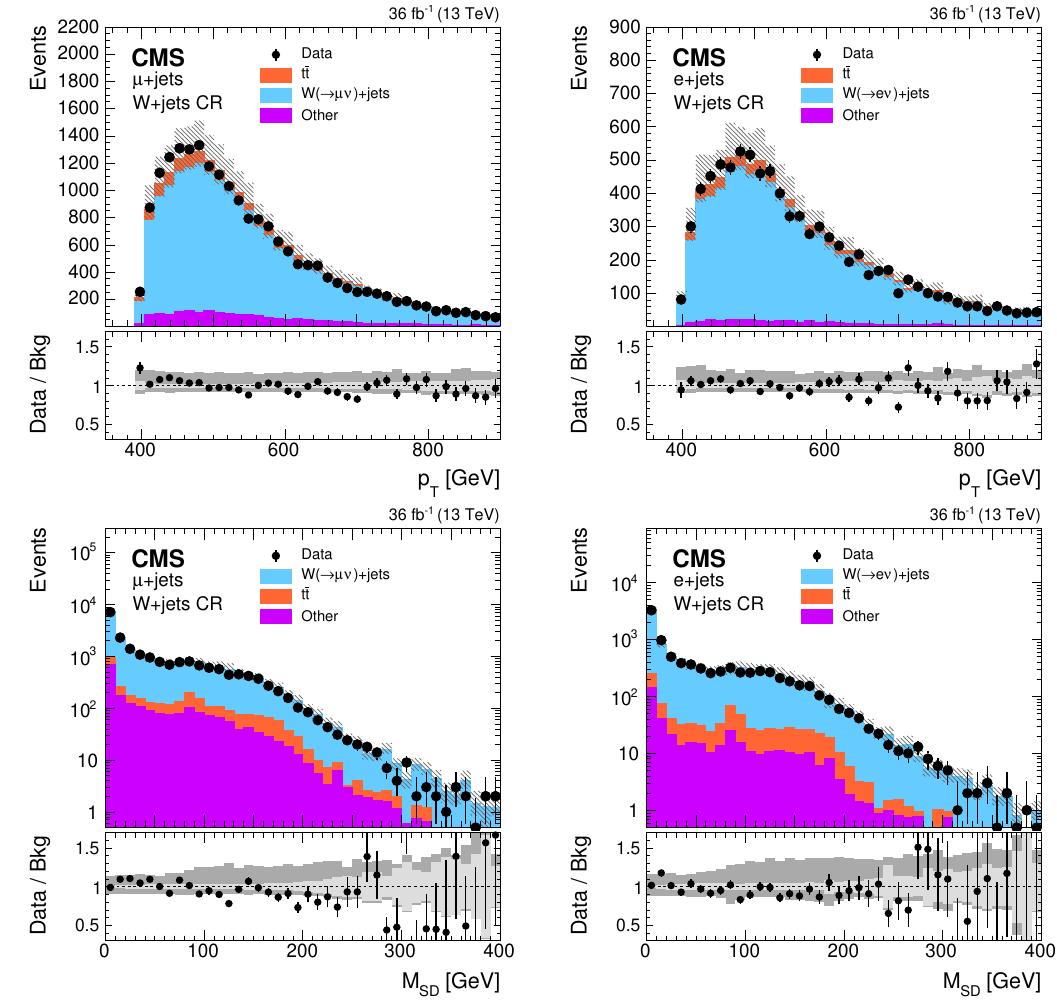
Figure 6 . Distributions of p T (upper) and m SD (lower) for the W+jets background in the muon (left) and electron (right) channels using the W+jets mistag CR. The jet p T information is taken from the CHS jets, while the m SD is take from the PUPPI jets. The hatched band on the simulation represents the uncertainty in the background prediction. The lower panels in each plot show the ratio of data to the SM background prediction and the light (dark) gray band represents statistical (systematic)